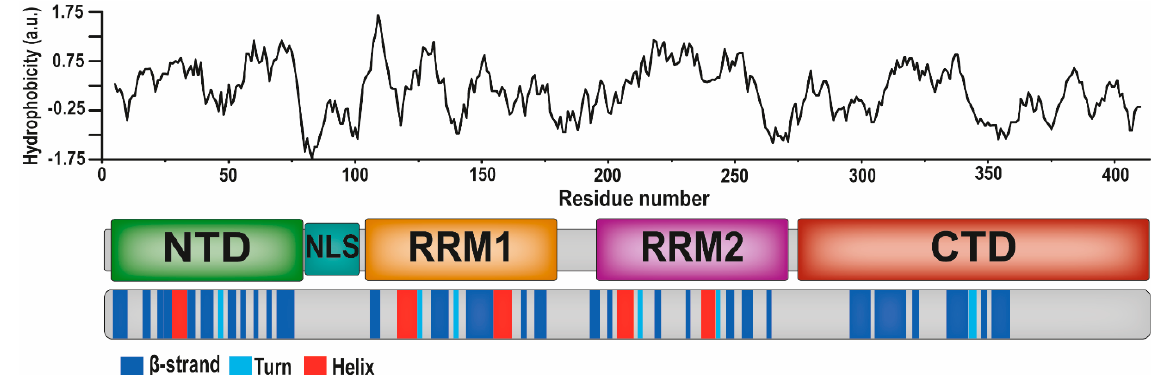
Figure 2. The different domains of the TDP-43 protein, including their hydrophobicities and secondary structures ( β -strand, turn, helix, or unstructured). NTD—N-terminal domain; NLS—nuclear localization signal domain; RRM1 and RRM2—RNA recognition motifs 1 and 2; CTD—C-terminal domain [34,101]. Original drawing by E.B.